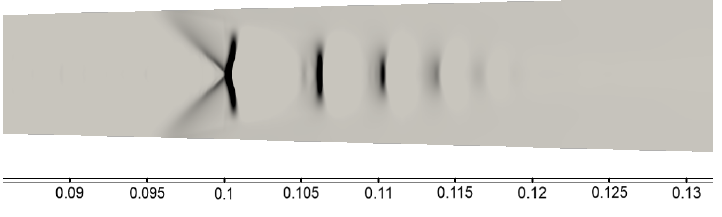
Figure 5. Results obtained by the author during current study for a qualitative comparison with experimental taken from [34].